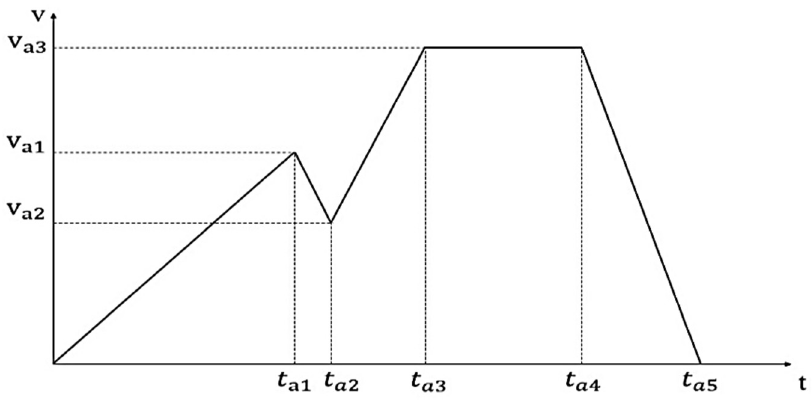
Figure 2. Cycle A of an EV.